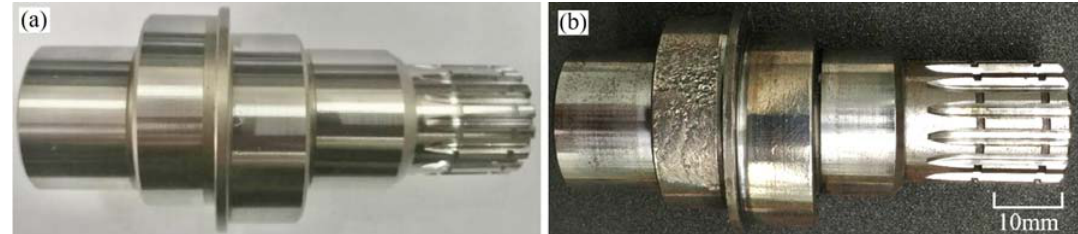
Figure 2. Macroscopic morphology of crankshaft: ( a ) the new part; ( b ) the failed part. The SEM micrographs of the eccentric cylindrical surface of the crankshaft before and